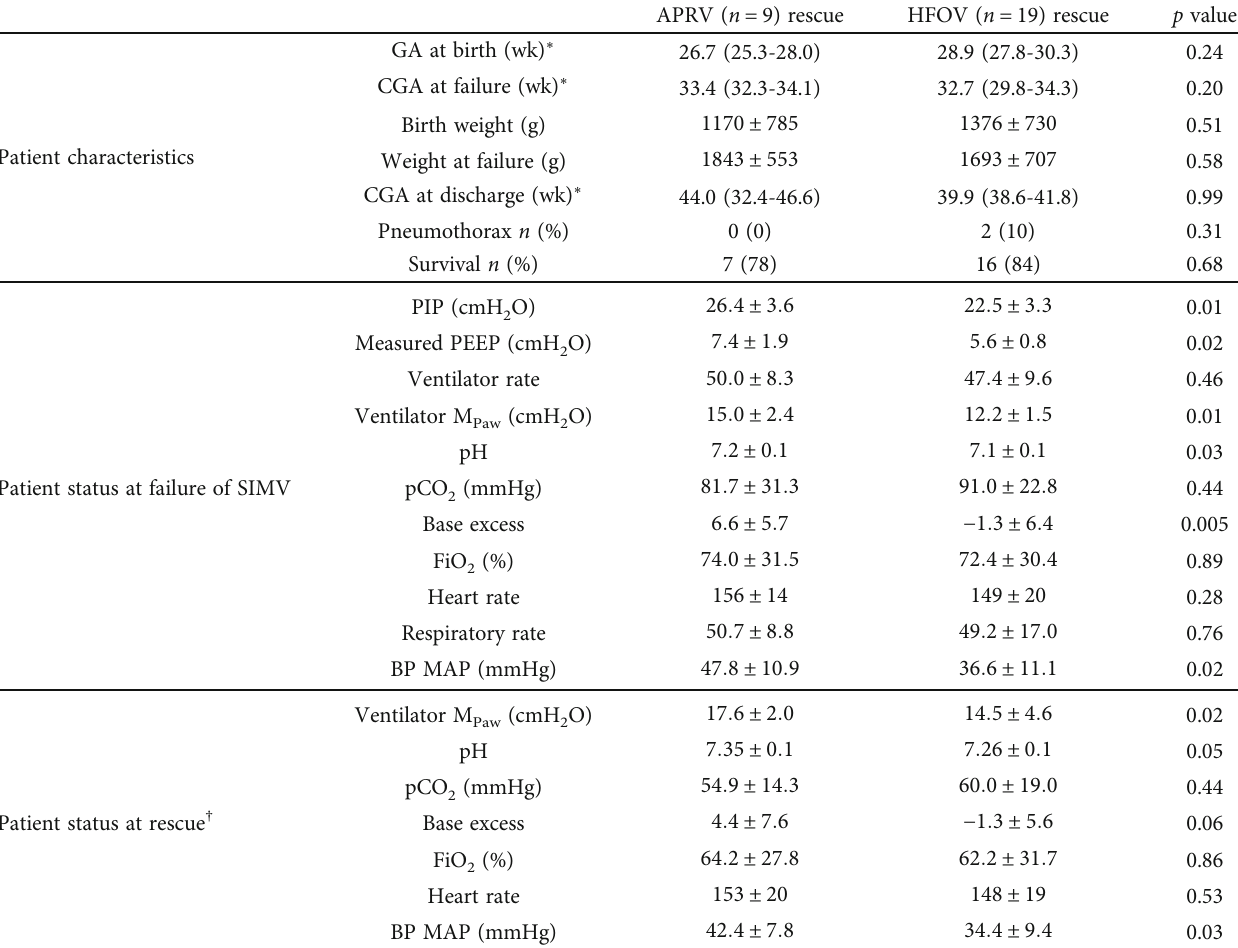
Table 2: Infants grouped by corrected gestational age (CGA) at failure (28-37